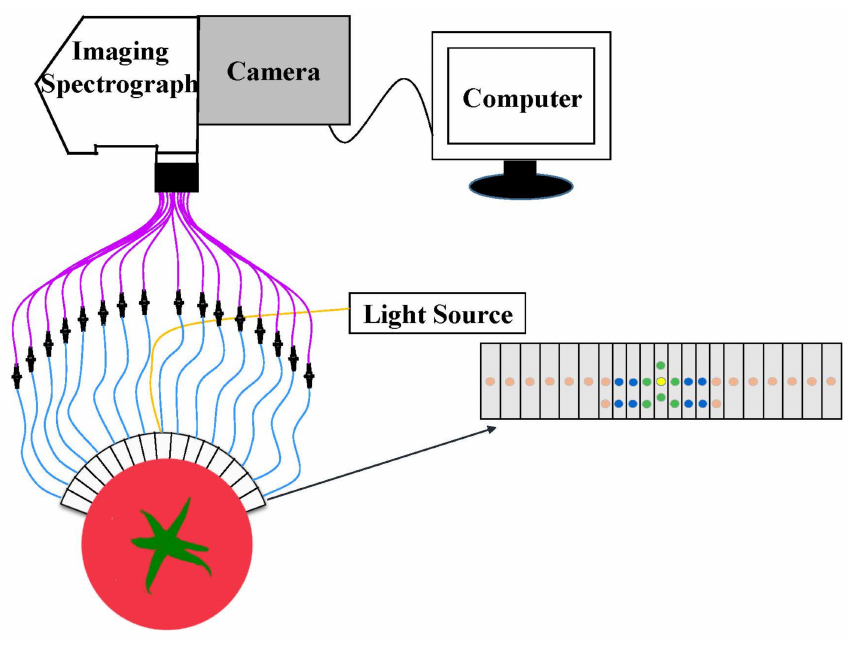
Figure 5. The configuration of the multi-channel curved array of